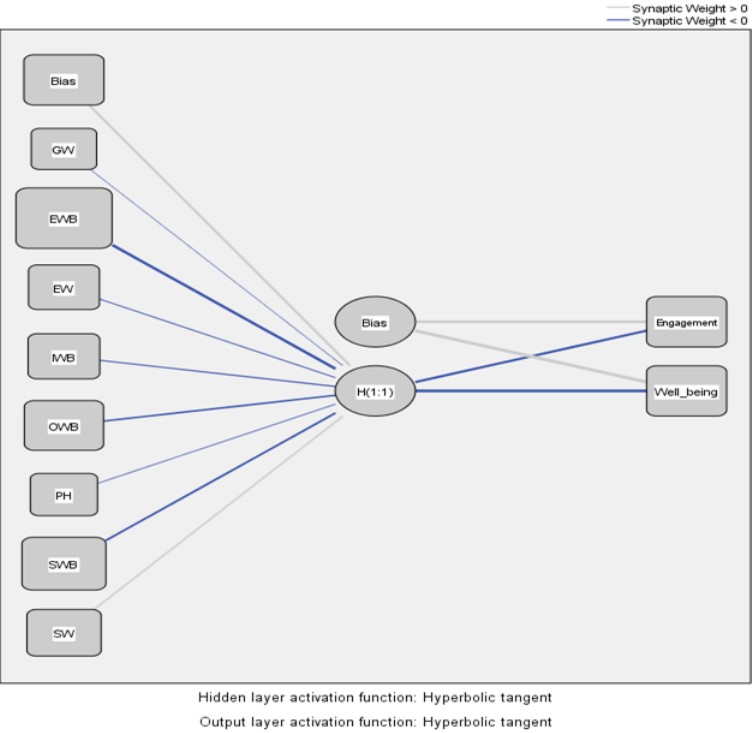
Figure 6. MLP model for identifying the influences of WB dimensions on the overall level of EE and WB. Source: Developed using SPSS v.20 (SPSS Inc., Chicago, IL, USA).